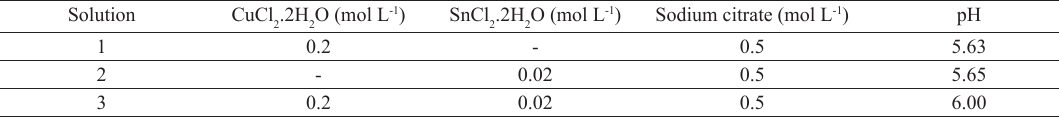
Table 1. Chemical composition and pH values of solutions used in electrochemical tests. Solution